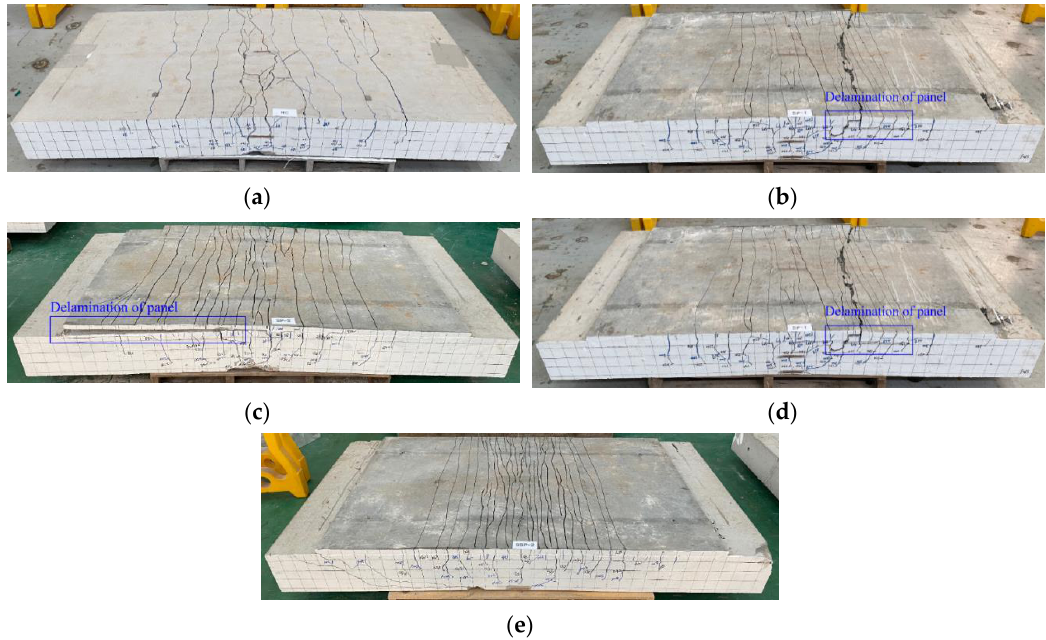
Figure 10. Cracked patterns on the bottom side of specimens after failure (photo): ( a ) RC; ( b ) SP-1; ( c ) SP-2; ( d ) SSP-1; ( e ) SSP-2.